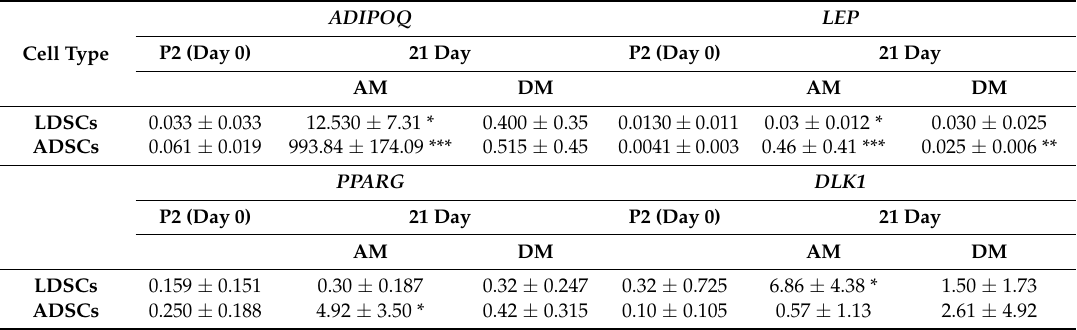
Table 1. Relative expression of ADIPOQ , LEP , PPARG and DLK1 in LDSCs and ADSCs at day 21 of adipogenic differentiation, normalized to GAPDH and compared to the cells at P2 (day 0). Results are expressed as mean values ± SD. Asterisks represent statistical significance compared to P2 (day 0).